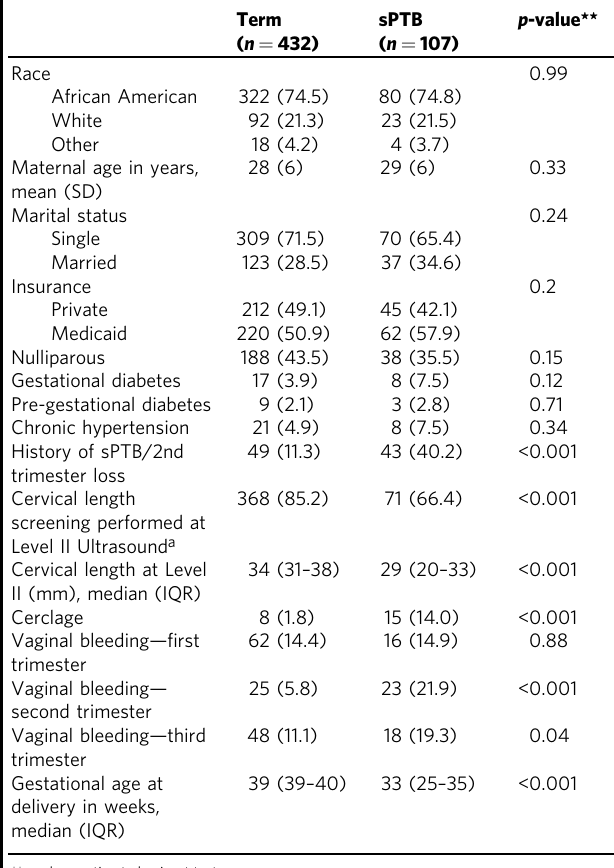
Table 1 M&M participants demographics and